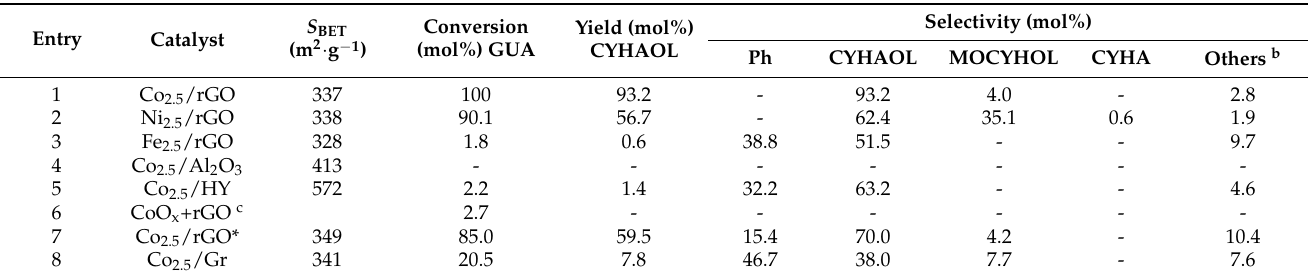
Table 2. HDO of GUA over the prepared catalysts a .